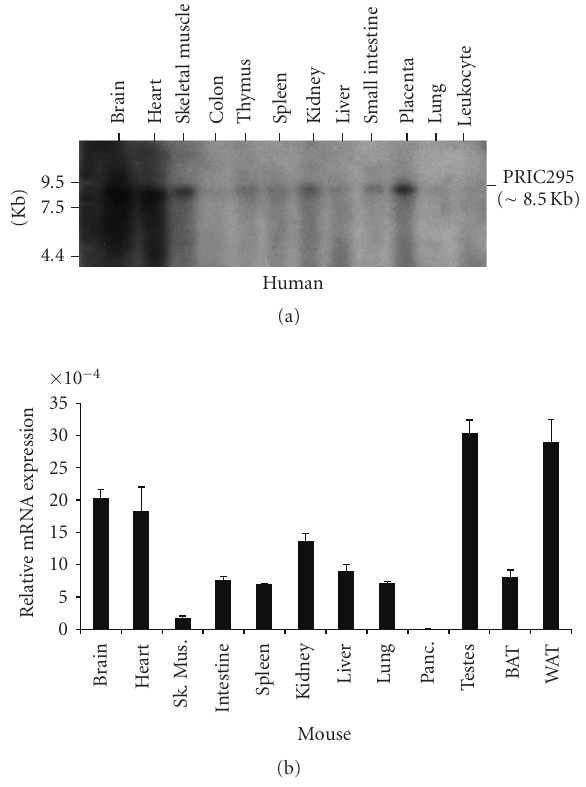
Figure 3: Expression of PRIC295 in human and mouse tissues. (a) Northern blot analysis of PRIC295 mRNA expression using a human multiple tissue blot (Clontech). Blot contains 2 μ g of polyA RNA in each lane from tissues indicated. PRIC295 transcript ( ∼ 8.5kb) is expressed in nearly all tissues. (b) Quantitative PCR data showing the expression of PRIC295 mRNA in several di ff erent mouse tissues. Primers were designed to amplify from the exon 27- 28 region of the cDNA sequence. Samples were normalized with 18S RNA. RNA from 5 di ff erent C57B6/J males was pooled and samples were run in triplicate. Standard deviations are